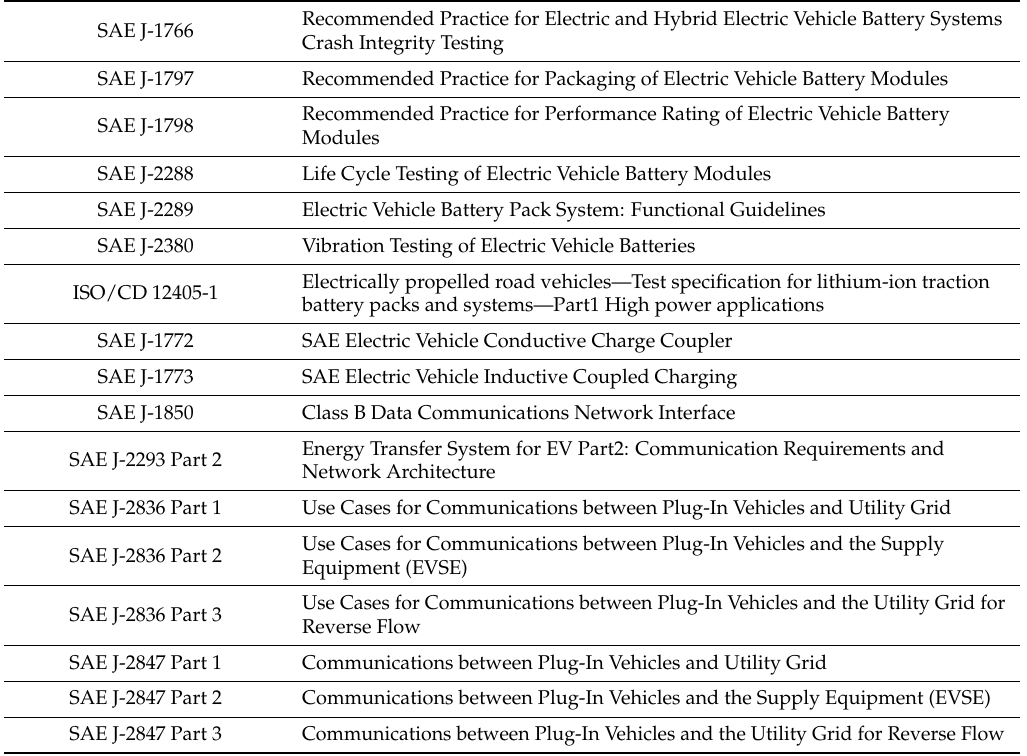
Figure 5. Communication Network Architecture. Table 1. Communication Network: SAE standard codes for EV batteries and interfaces.